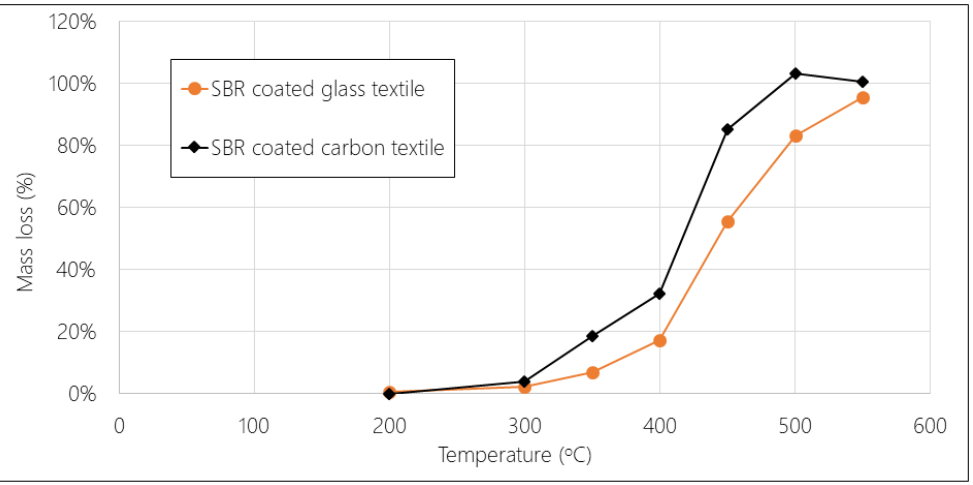
Figure 7. Mass loss of the textiles’ coating after heating to different temperatures.